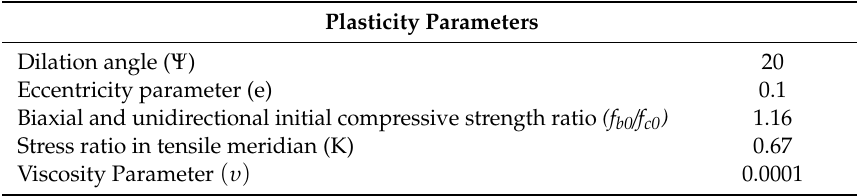
Table 9. Concrete damage plasticity of masonry brick and